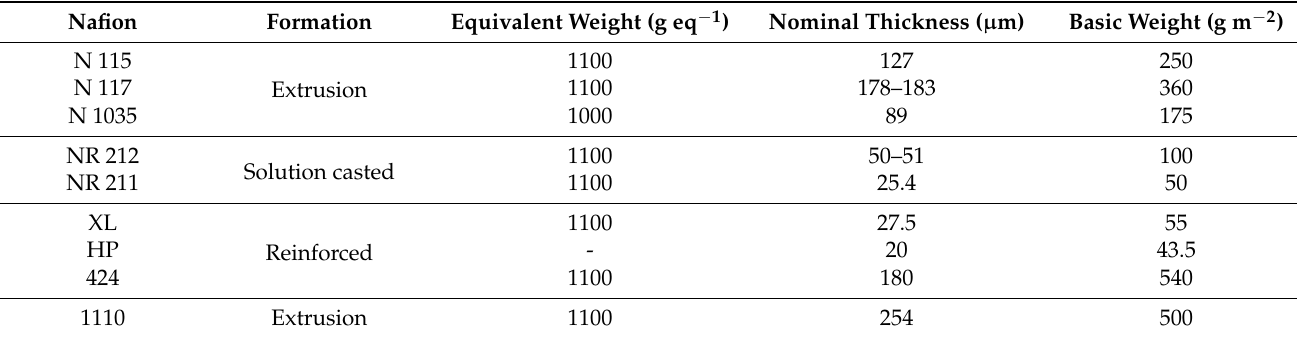
Table 2. Commercially available Nafion membranes with their respective